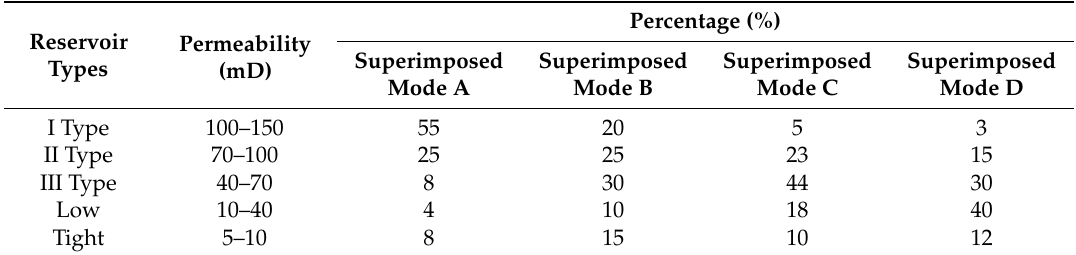
Table 1. The permeability distribution of the different superimposed modes.